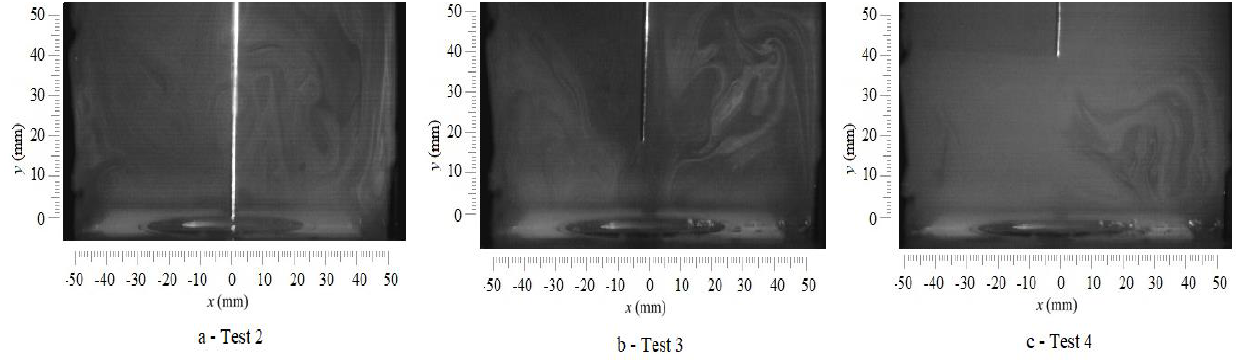
Figure 7. Comparative analysis of smoke flow visualizations at different standoff distances 0 mm, 20 mm, and 40 mm at fixed percentage of amplitude.